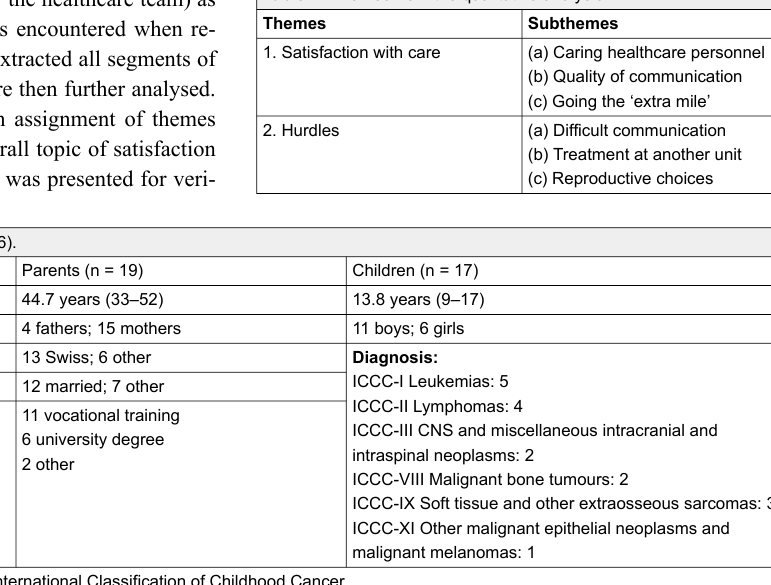
Table 2: Themes from the qualitative analysis.